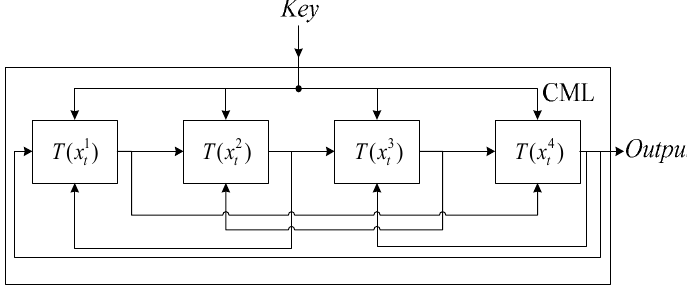
where n = 1, 2, . . . , N , N = 4. The q ( x ) is the chaotic tent map, i is a counter and Q = 512 is a fixed integer. The simulation algorithm is similar to Figure 8, but the chaotic map is a tent map q ( x ).